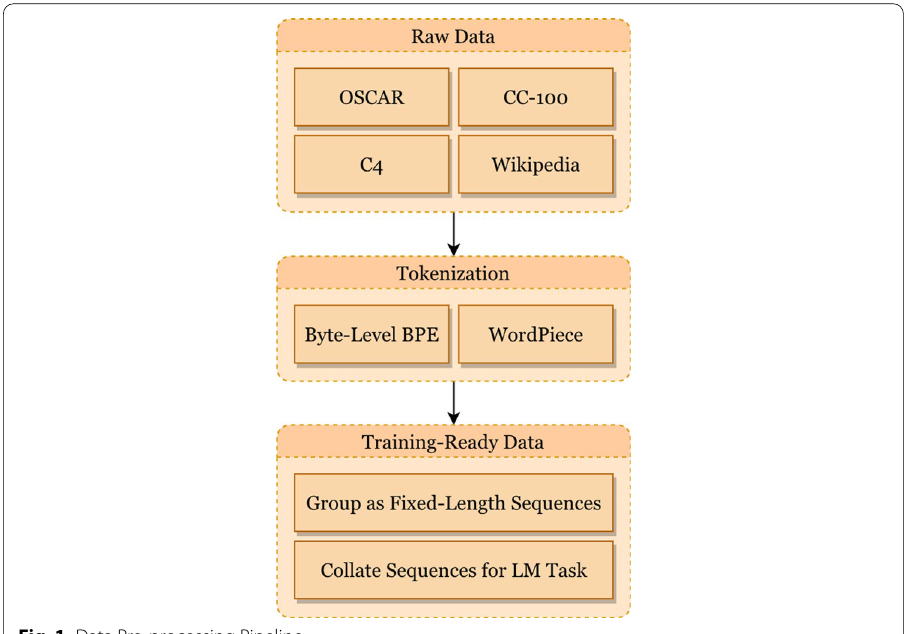
Fig. 1 Data Pre-processing